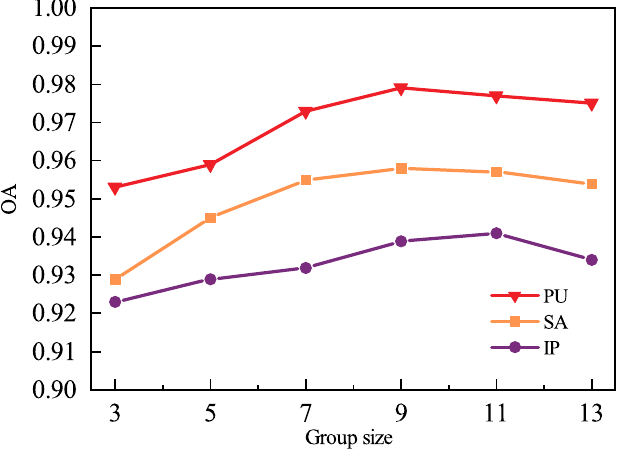
Figure 7. OA of NEHT network with different group size in the PU, SA and IP data